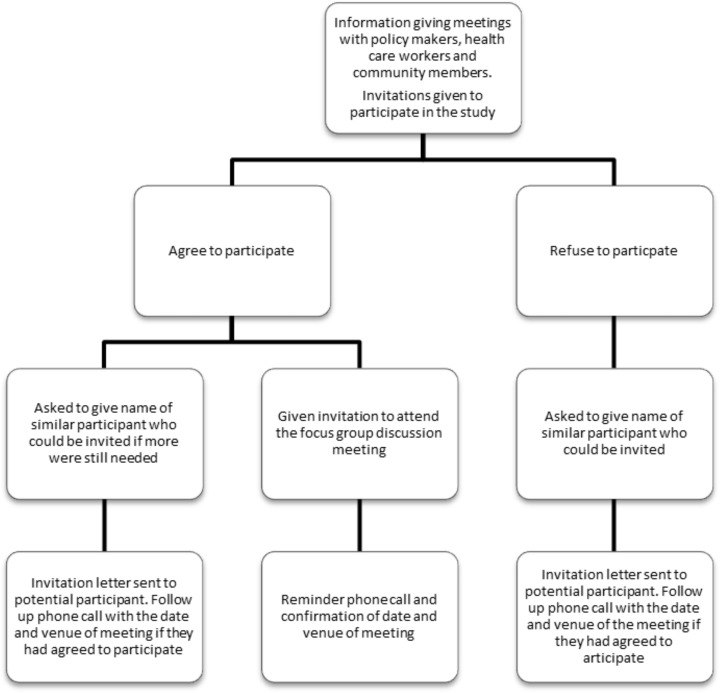
Sampling Strategy.